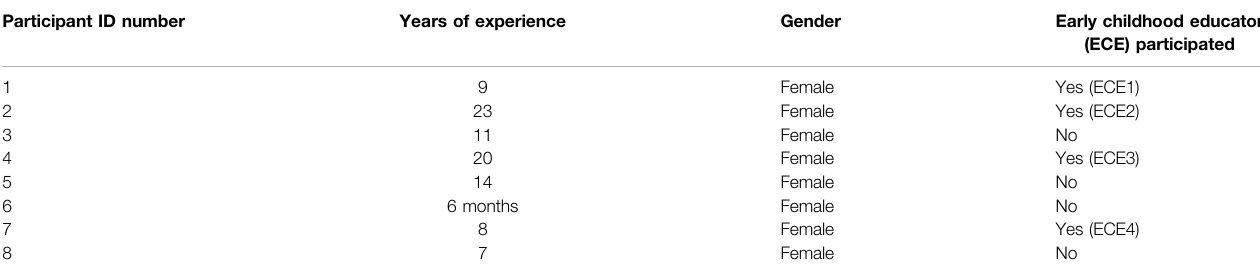
TABLE 1 | Demographic data for